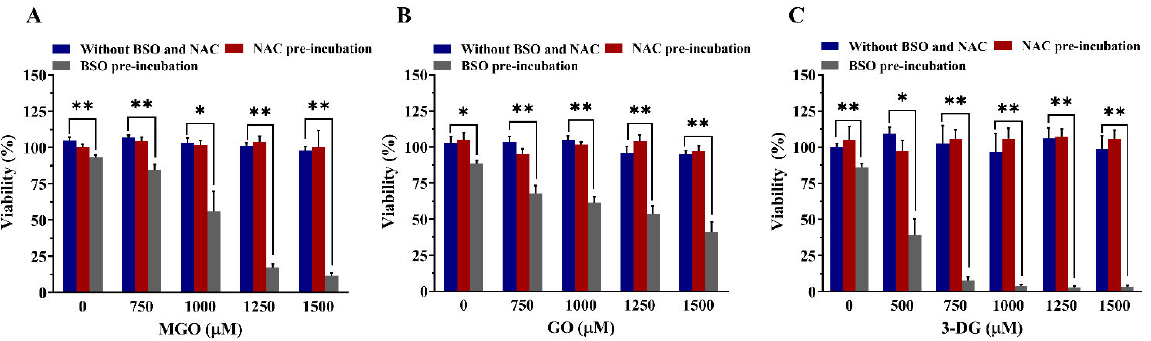
Figure 9. Effects of altered intracellular GSH levels on the cell viability upon exposure of Nrf2 cells to MGO ( A ), GO ( B ), and 3-DG ( C ) for 24 h. Data are presented as mean ± SEM of at least CALUX cells to MGO ( A ), GO ( B ), and 3 ‐ DG ( C ) for 24 h. Data are presented as mean ± SEM of at three independent replicates. * p < 0.05 and ** p < least three independent replicates. * p < 0.05 and ** p < 0.01.